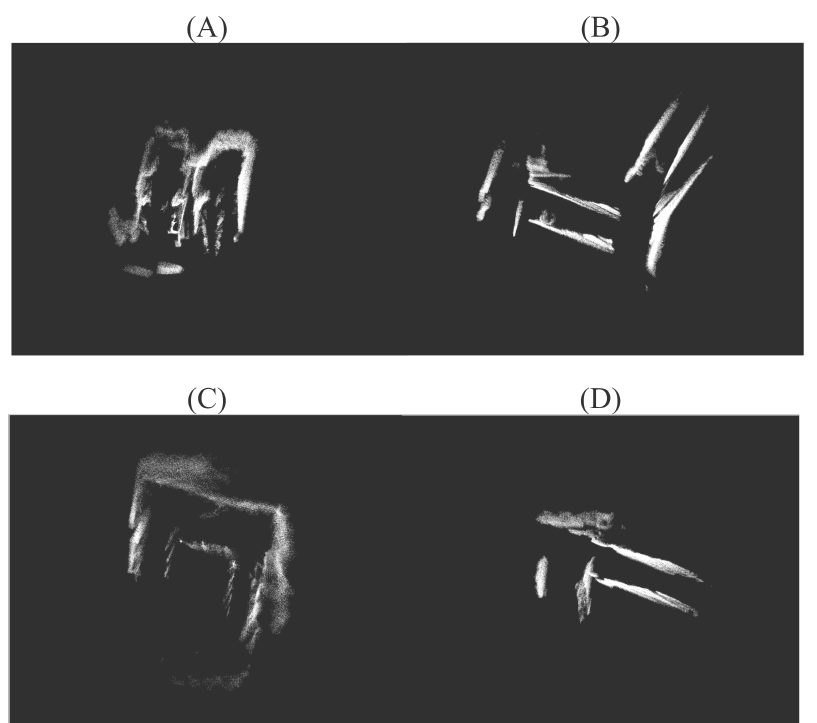
Figure 9. Example of the dense point cloud map for ( A ) the U-shaped hallway; ( B ) the H-shaped hallway; ( C ) the Loop-shaped hallway; ( D ) the T-shaped hallway.